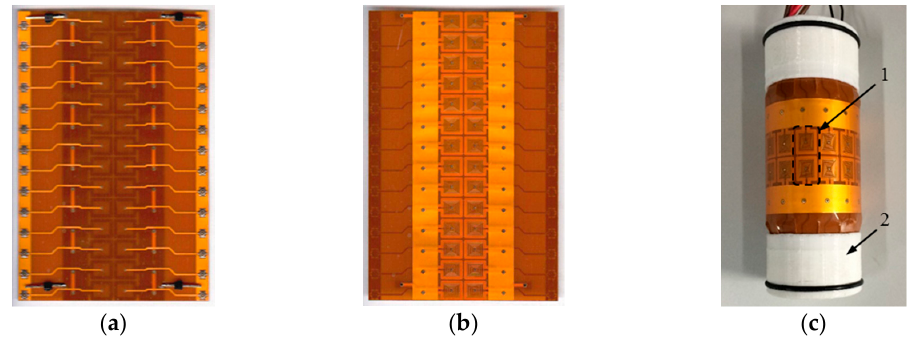
Figure 1. Novel flexible arrayed sensor ( a ) Bottom view of the unfolded sensor; ( b ) Top view of the unfolded sensor; ( c ) Actual sensor; 1—Differential sensing pair, 2—Sensor holder.